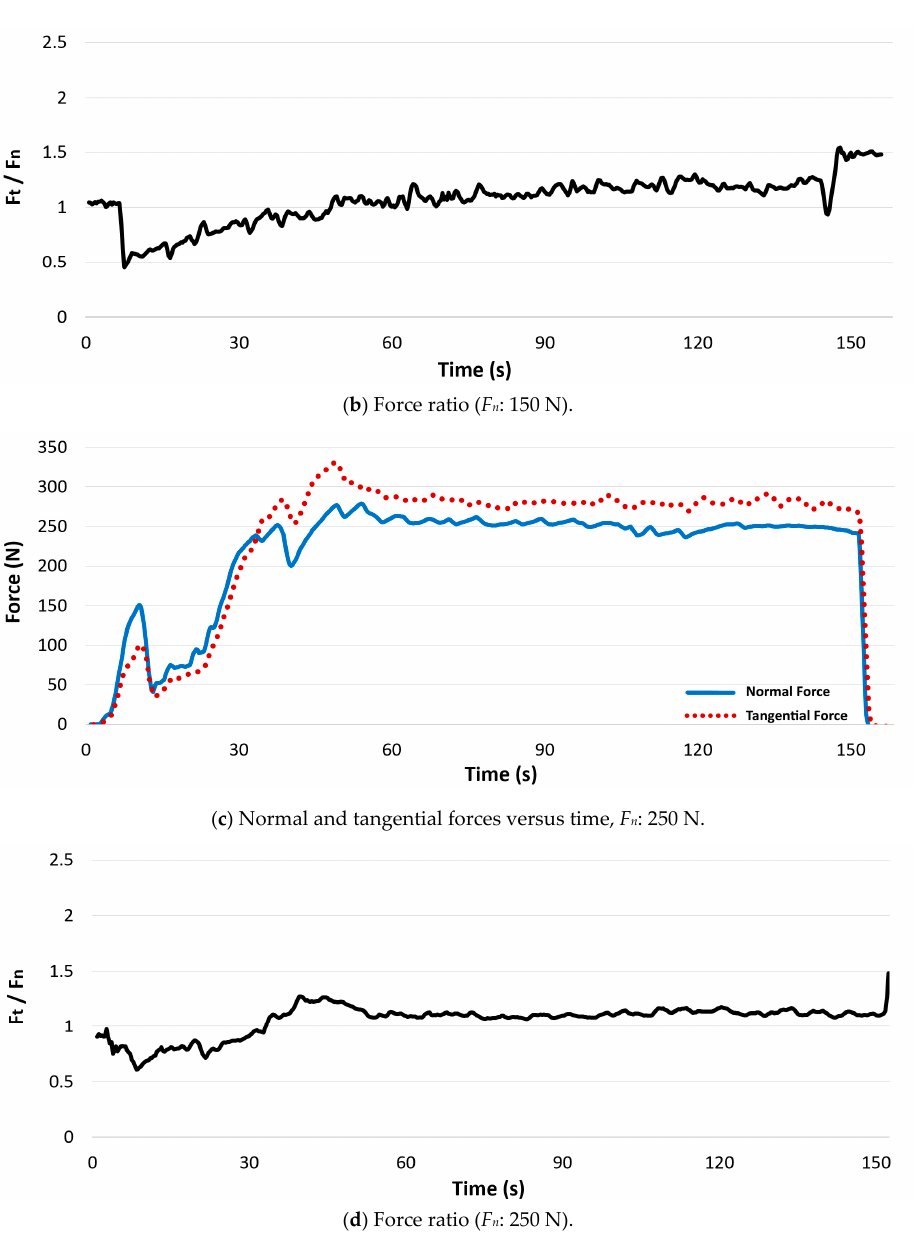
Figure 4. Manual controlling of the applied forces: ( a , c ) Normal and tangential forces versus time; ( b , d ) force ratio ( F t / F n ).